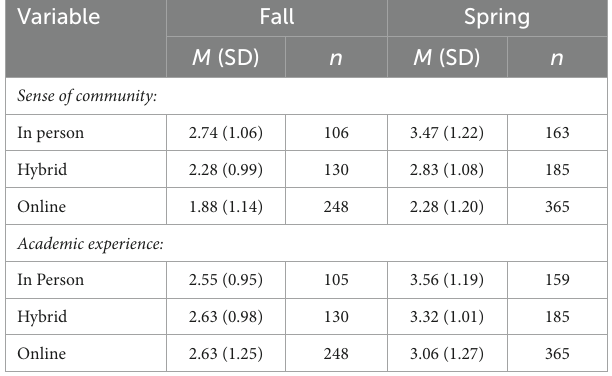
TABLE 2 Participants’ sense of community and academic experience by semester and class format.